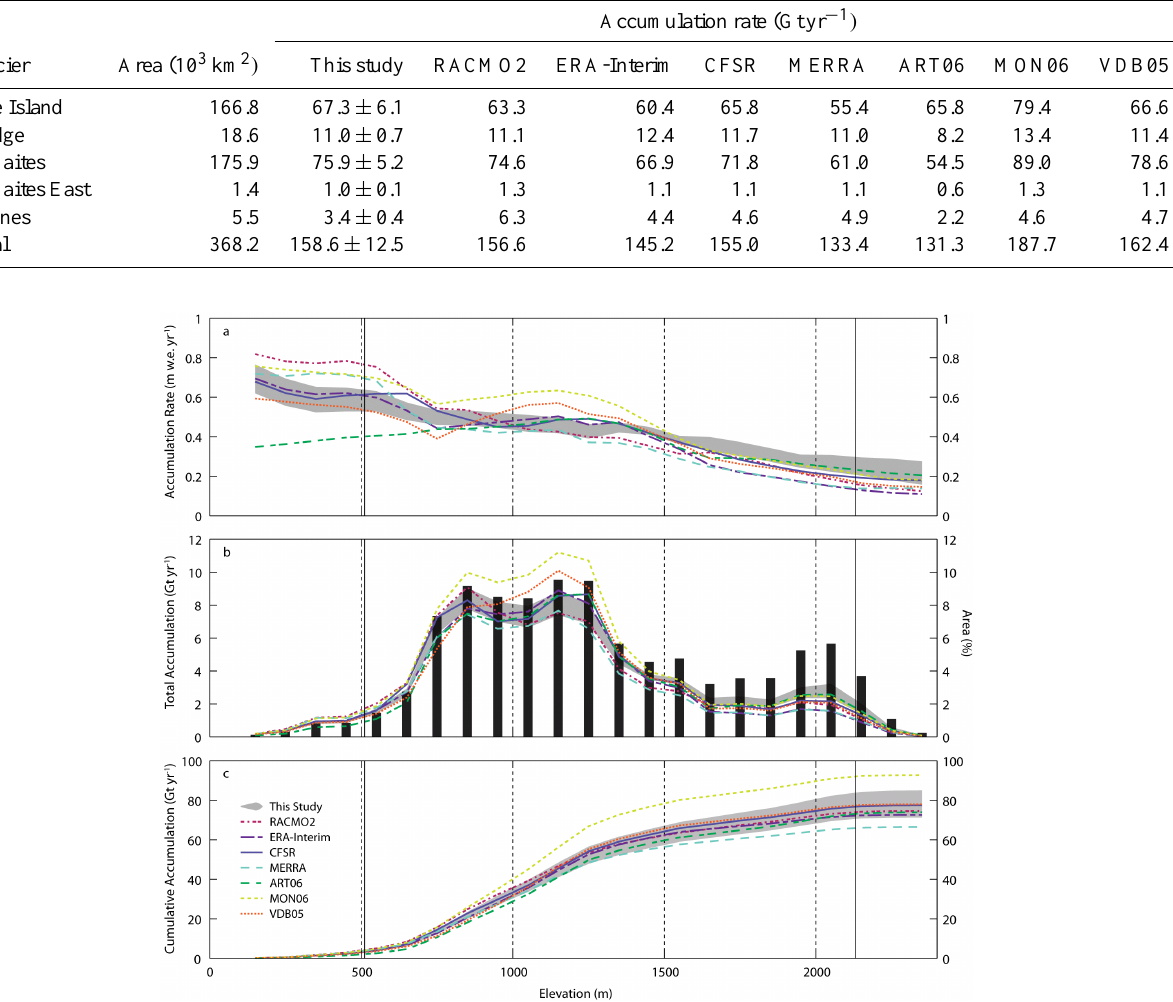
Table 3. Catchment-wide annual accumulation rate from climatologies, reanalysis products, and a climate model compared to this study.